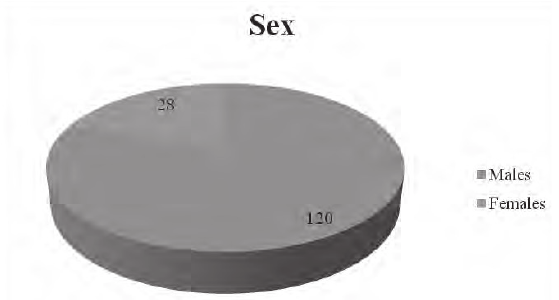
Figure 3: Figure showing the frequency of patients in different sexe s The most common cause of TBI was fall injury which